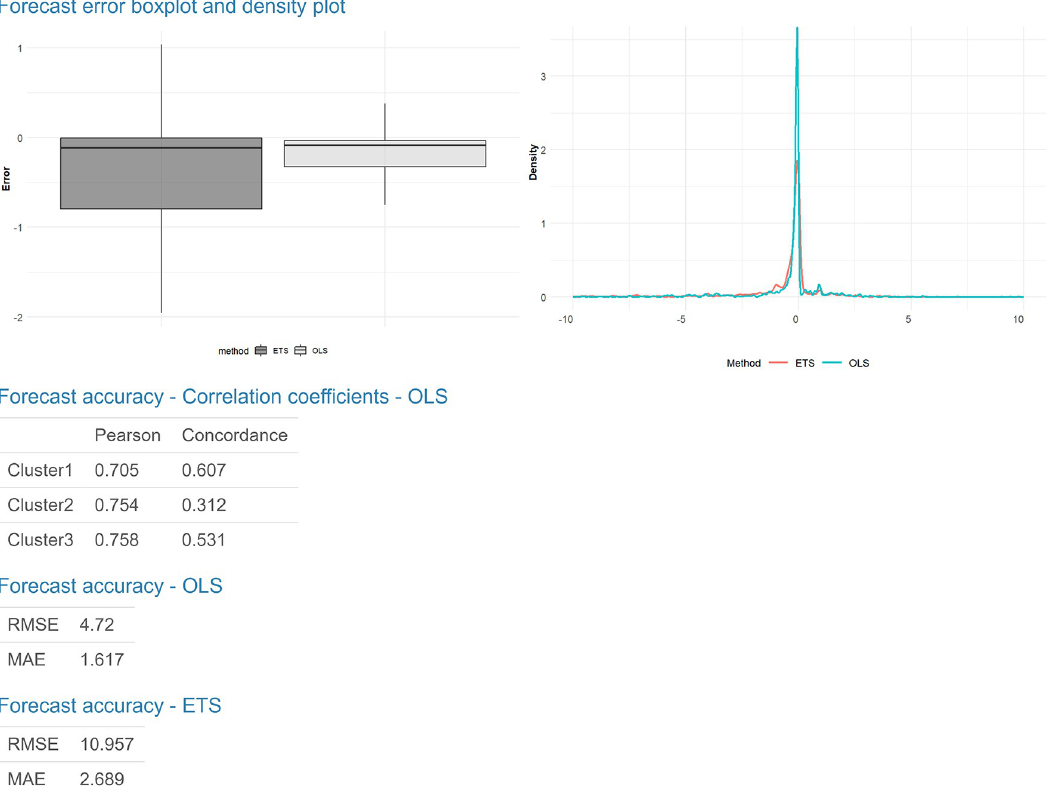
Fig 5. Clustering and forecasting Taiwan COVID-19 confirmed infection cases—Part